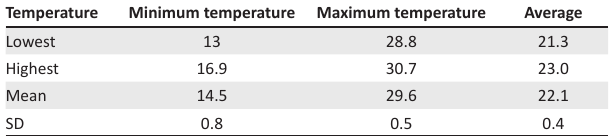
TABLE 8: Descriptive statistics of annual minimum and maximum temperature.